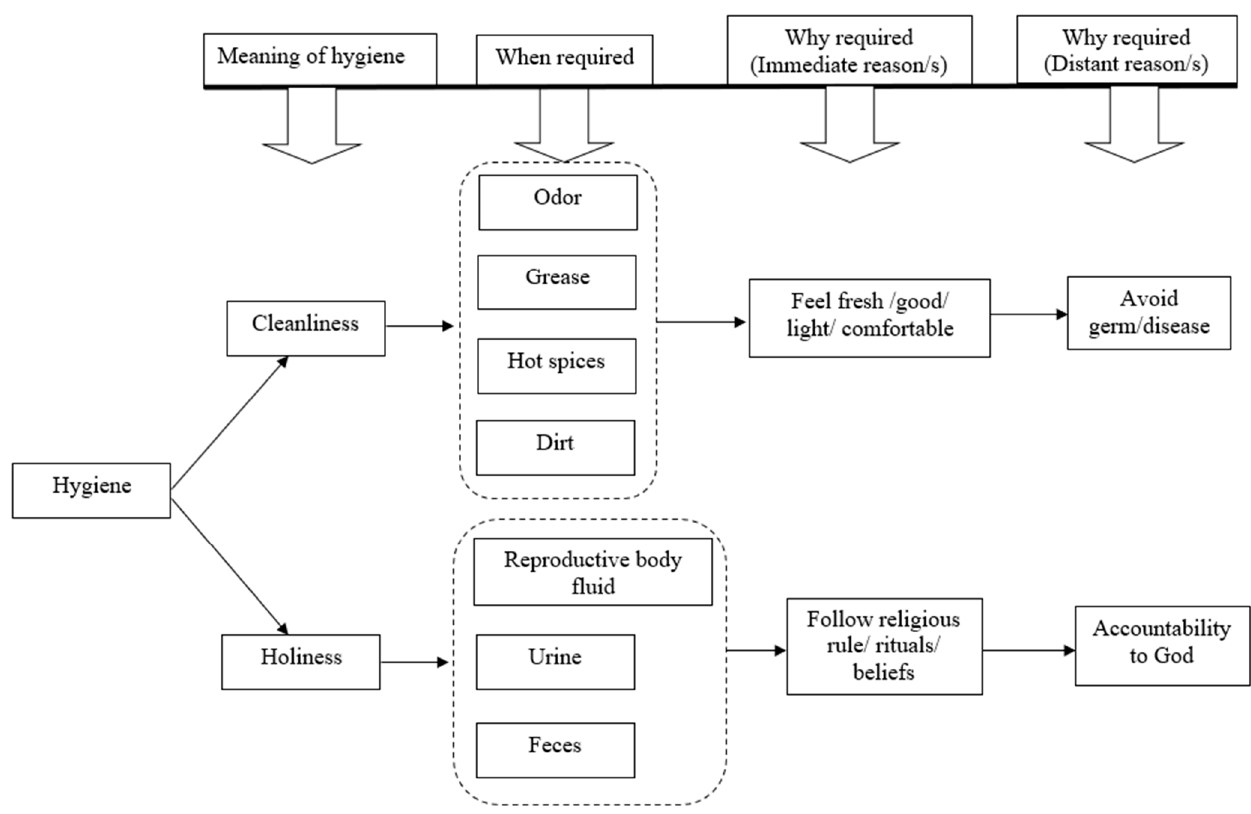
Figure 1. The concept of hygiene among the low-income urban residents of Arichpur, from Septem- ber 2014 to June 2016. 2014 to June